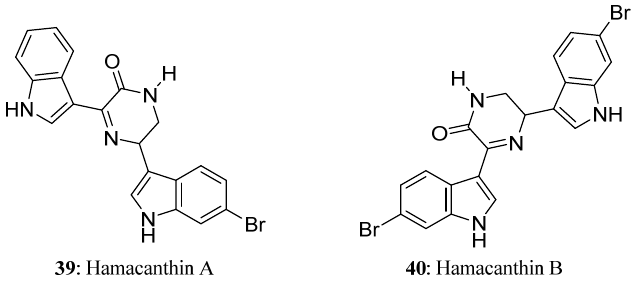
Figure 7. The structure of compounds 30 - 38 .